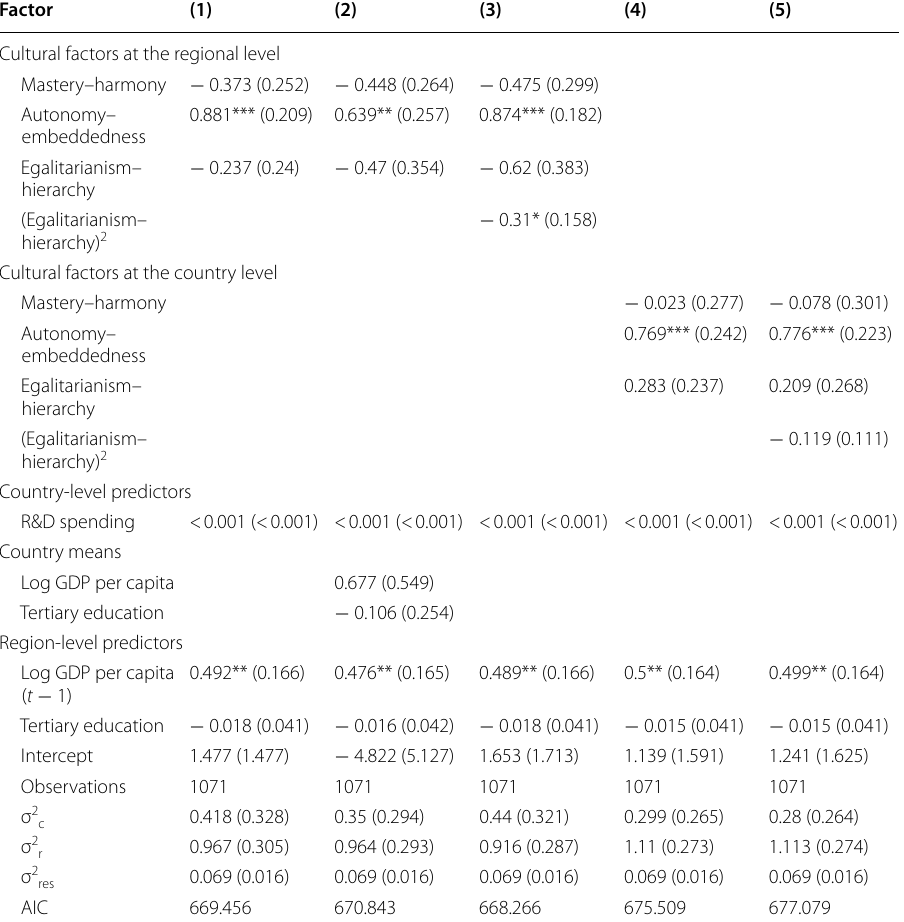
Table 5 Multilevel regressions on the regional-level patenting